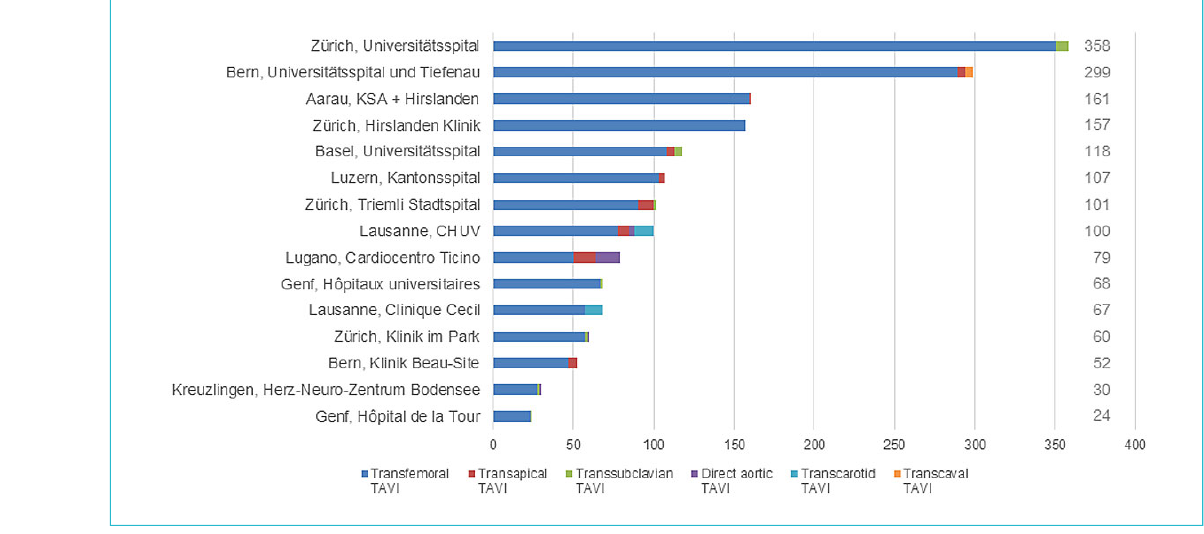
Figure 3: Transcatheter aortic valve implantations (TAVI) during the year 2018 in